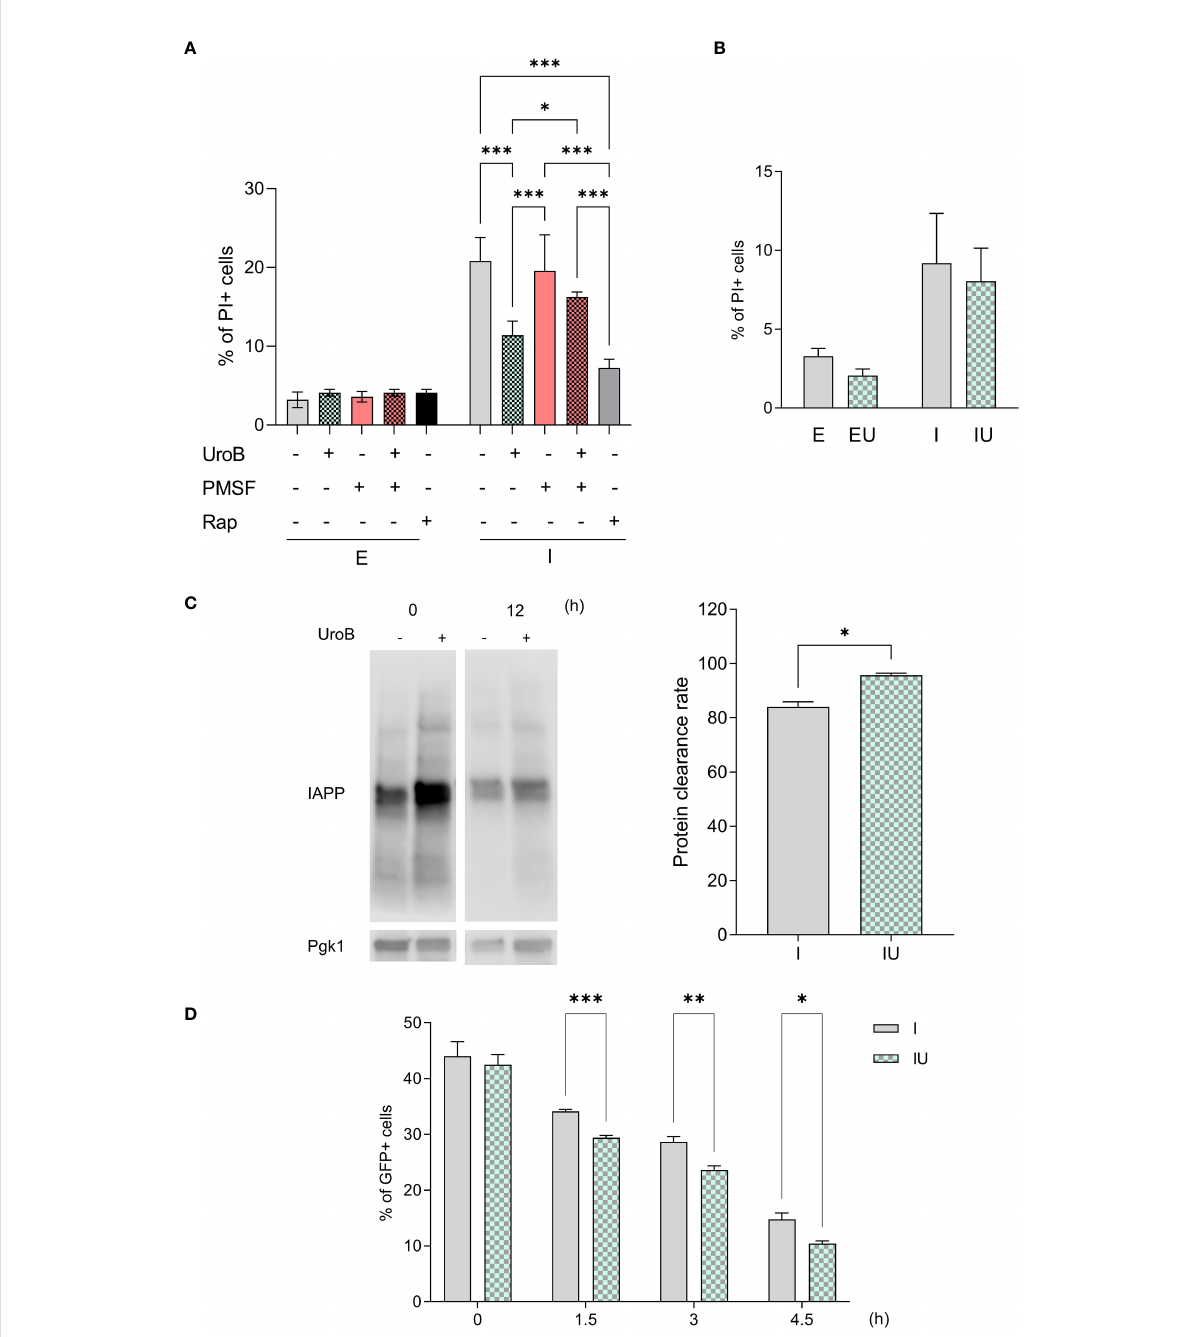
FIGURE 5 Autophagy and protein clearance contribute to urolithin B-mediated protection. (A) The frequency of propidium iodide (PI) positive cells assessed by fl ow cytometry in cells expressing ppIAPP and the respective control in the presence of 50 µM urolithin B (UroB), the autophagy blocker phenylmethylsulfonyl fl uoride (PMSF), or the autophagy inducer rapamycin (Rap); and (B) in cells lacking the ATG8 gene. (C) Protein clearance as assessed by immunoblotting. (D) The frequency of GFP positive cells by means of fl ow cytometry at the indicated time points after protein expression blockage. The values represent mean ± SD from at least three independent experiments. Statistical differences are denoted as ** p < 0.01, and *** p < 0.001 vs. the control condition. E, cells containing the empty vector; I, cells expressing ppIAPP; EU, cells containing the empty vector incubated with UroB; IU, cells expressing ppIAPP incubated with UroB; Pgk1, Phosphoglycerate kinase 1. Statistical differences are denoted as *p < 0.05, **p < 0.01, and ***p < 0.001 vs. the control